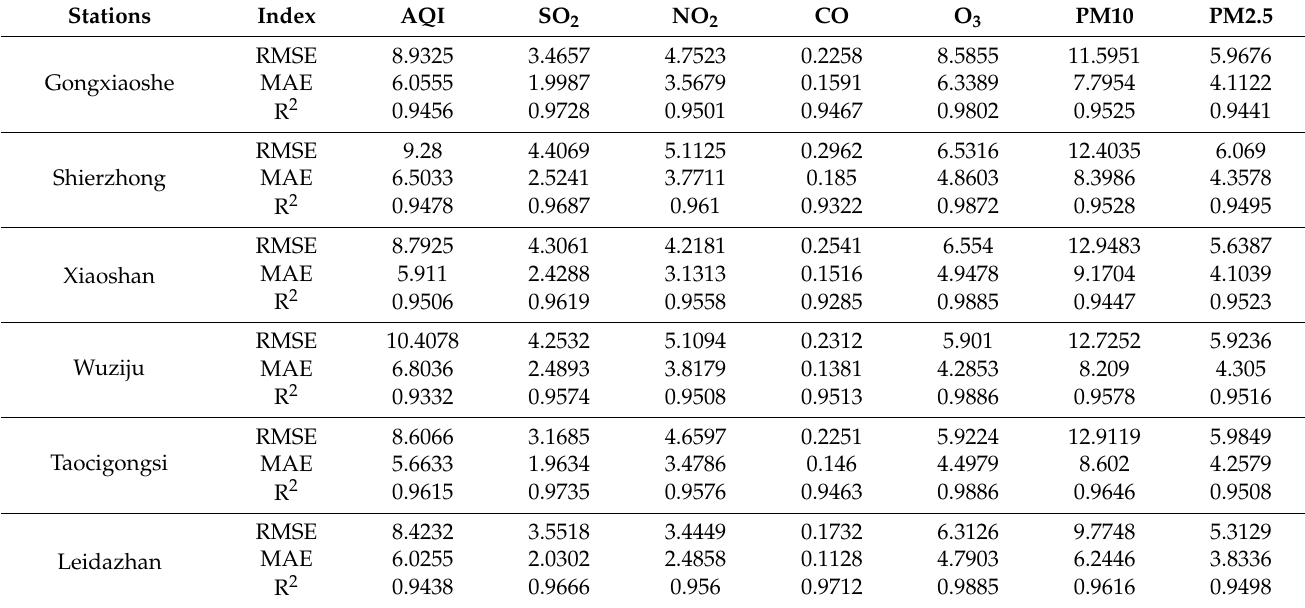
Table 2. The result evaluation of the prediction model.